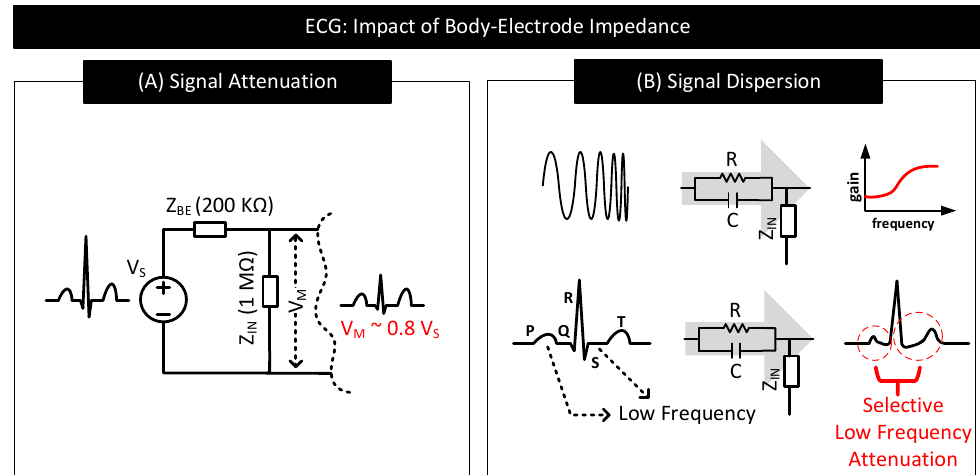
Figure 15. ( A ) Impact of contact impedance on biopotential signal measurement. When contact impedance is 20% of the input impedance of the measurement circuit, then only ≈ 80% of the signal ( V s ) drops at the input ( V in ) of the measurement circuit. ( B ) Distorted ECG waveform with P, S and T waves deformed and S-T segment modified due to significant attenuation in the low-frequency signal